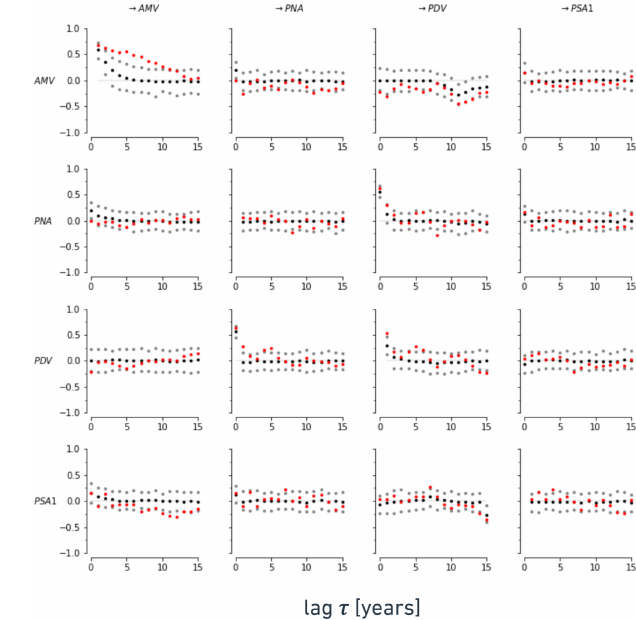
Figure 6. Lagged correlations of original data (lag in years; complete-period graph from reanalysis data) in red, shown together with lagged correlations of an ensemble of synthetic data gener- ated by a linear Gaussian structural causal model, with causal co- efficients and noise structure estimated from the original data. The mean lagged correlations from the synthetically generated data are shown in black, and their 5th–95th percentile ranges are shown in gray. The x axis shows lag in